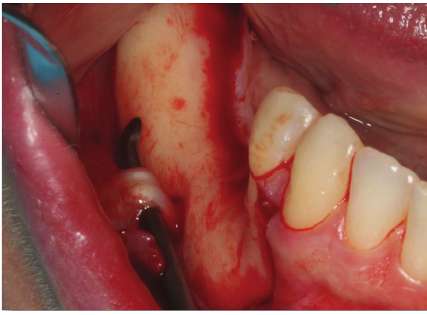
Figure 1: Incision and